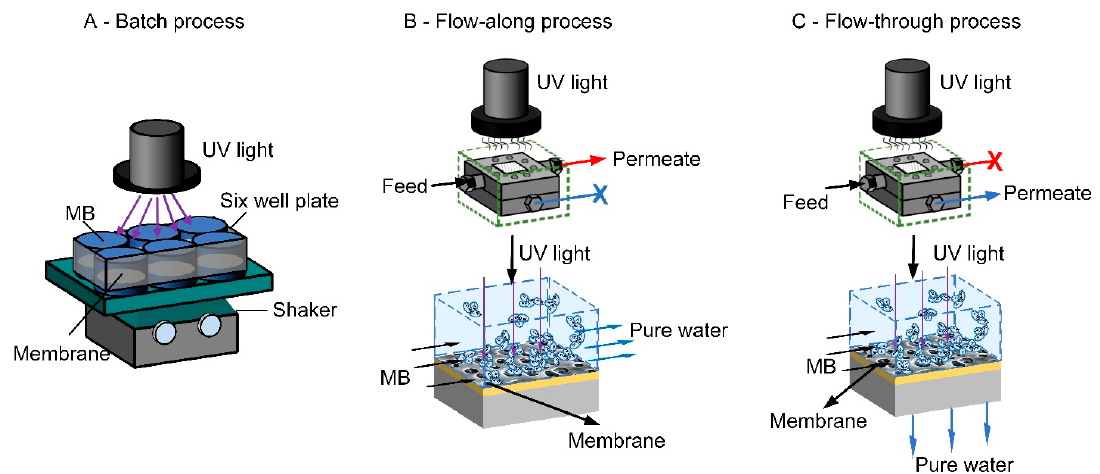
Figure 1 Schematic of reactors with different flow processes: (A) batch, (B) flow-along, (C) flow-through. Figure1. Schematicofreactorswithdi ff erentflowprocesses: ( A )batch, ( B )flow-along, ( C